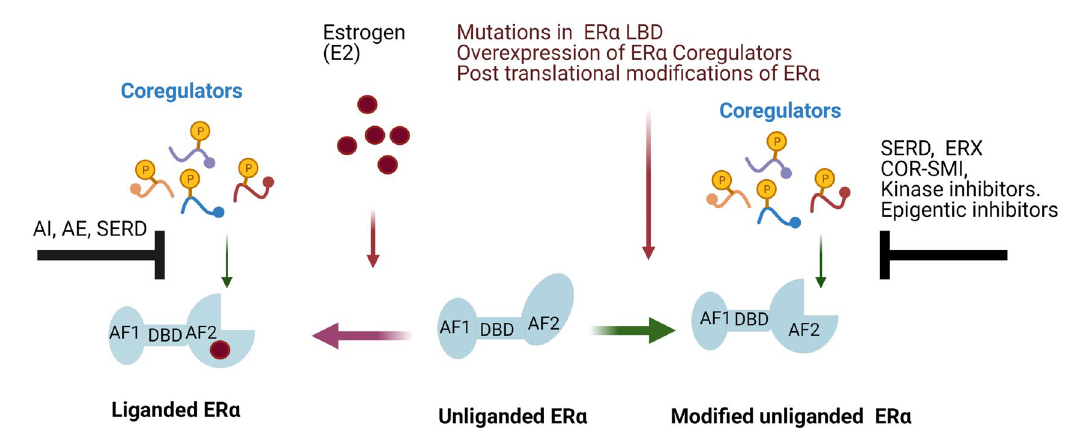
Figure 3. Approaches to target ERα-coregulator oncogenic signaling in BC. Ligand binding to the LBD of ERα facilitates coregulator recruitment and activation of ERα down-stream signaling. Ligand driven ERα-coregulator signaling can be targeted using AIs (such as letrozole), AEs (such as tamoxifen), and SERDs (such as fulvestrant). Cytosolic signaling kinases such as Src, AKT, mTOR, and CDKs form complexes with ERα; and can phosphorylate ER and its coregulators leading to activation of ERα non-genomic signaling cascades. Therefore, targeting these kinases with pharmacological inhibitors will be useful in reducing ERα coregulator driven non-genomic signaling. Several pathological scenarios such as overexpression of ERα coregulators, epigenetic changes, post translational modifications, and mutations in ERα AF2 domain can facilitate ligand-independent ERα signaling by recruiting coregulators. ERα signaling induced by oncogenic coregulators such as SRC1, SRC3, and PELP1 can be blocked by LxxLL motif blocking drugs called ERXs and SRC-3 small molecule inhibitor (SI-1) for SRC3 and inhibitors of epigenetic modifiers HDAC inhibitors (HDACi). Mutations in ERα create constitutive binding of coregulators to mtER and this signaling can be blocked